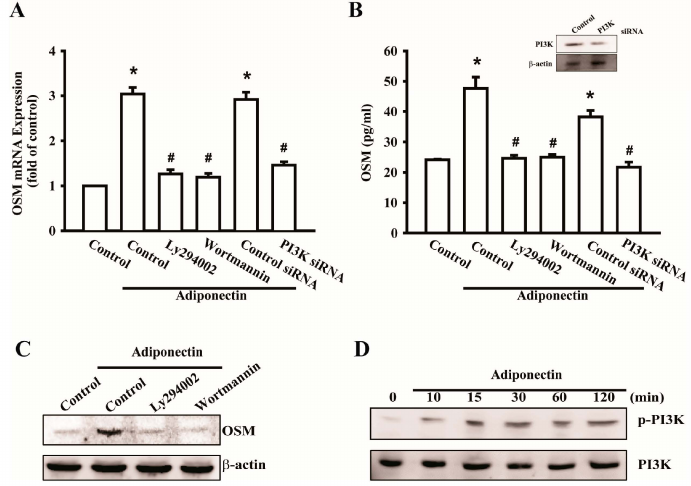
Figure 2. Signaling pathways of phosphatidylinositol 3-kinase (PI3K) involved in potentiating action of adiponectin. ( A ) Osteoblasts were pretreated with PI3K inhibitors, LY294002 (10 µ M) or Wortmannin (5 µ M), or transfected with p85 short interference RNA (siRNA) (0.5 nM) for 24 h followed by stimulation with adiponectin (100 ng/mL), OSM expression was measured by qPCR ( n = 6); ( B ) Cells were transfected with p85 siRNA (0.5 nM) for 24 h, the protein level of PI3K was measured by Western blot ( upper-panel ), and supernatant medium was collected to measure OSM expression by ELISAassay ( lower-panel ) ( n = 4); ( C ) Cells were pretreated with PI3K inhibitors, LY294002 (10 µ M) or Wortmannin (5 µ M), for 30 min followed by stimulation with adiponectin (100 ng/mL), the protein level of OSM was measured by Western blot ( n = 5); ( D ) Osteoblasts were incubated with adiponectin (100 ng/mL) in time intervals, and phosphate-PI3K expression was investigated by Western blot ( n = 6). Results are expressed as mean ˘ S.E.M. *, p < 0.05 compared with control; # , p < 0.05 compared with adiponectin-treated